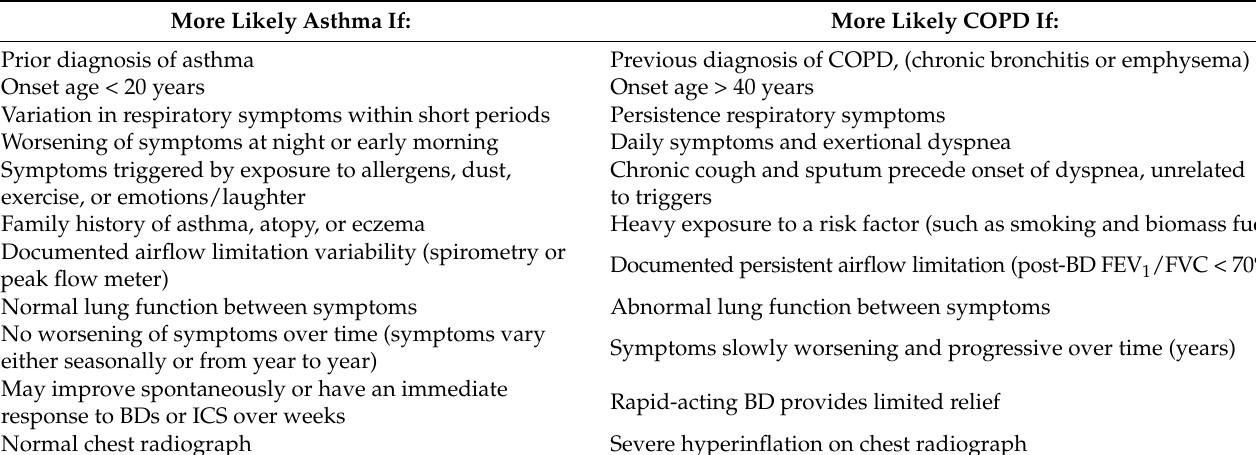
Table 1. Clinical features of asthma, COPD, and